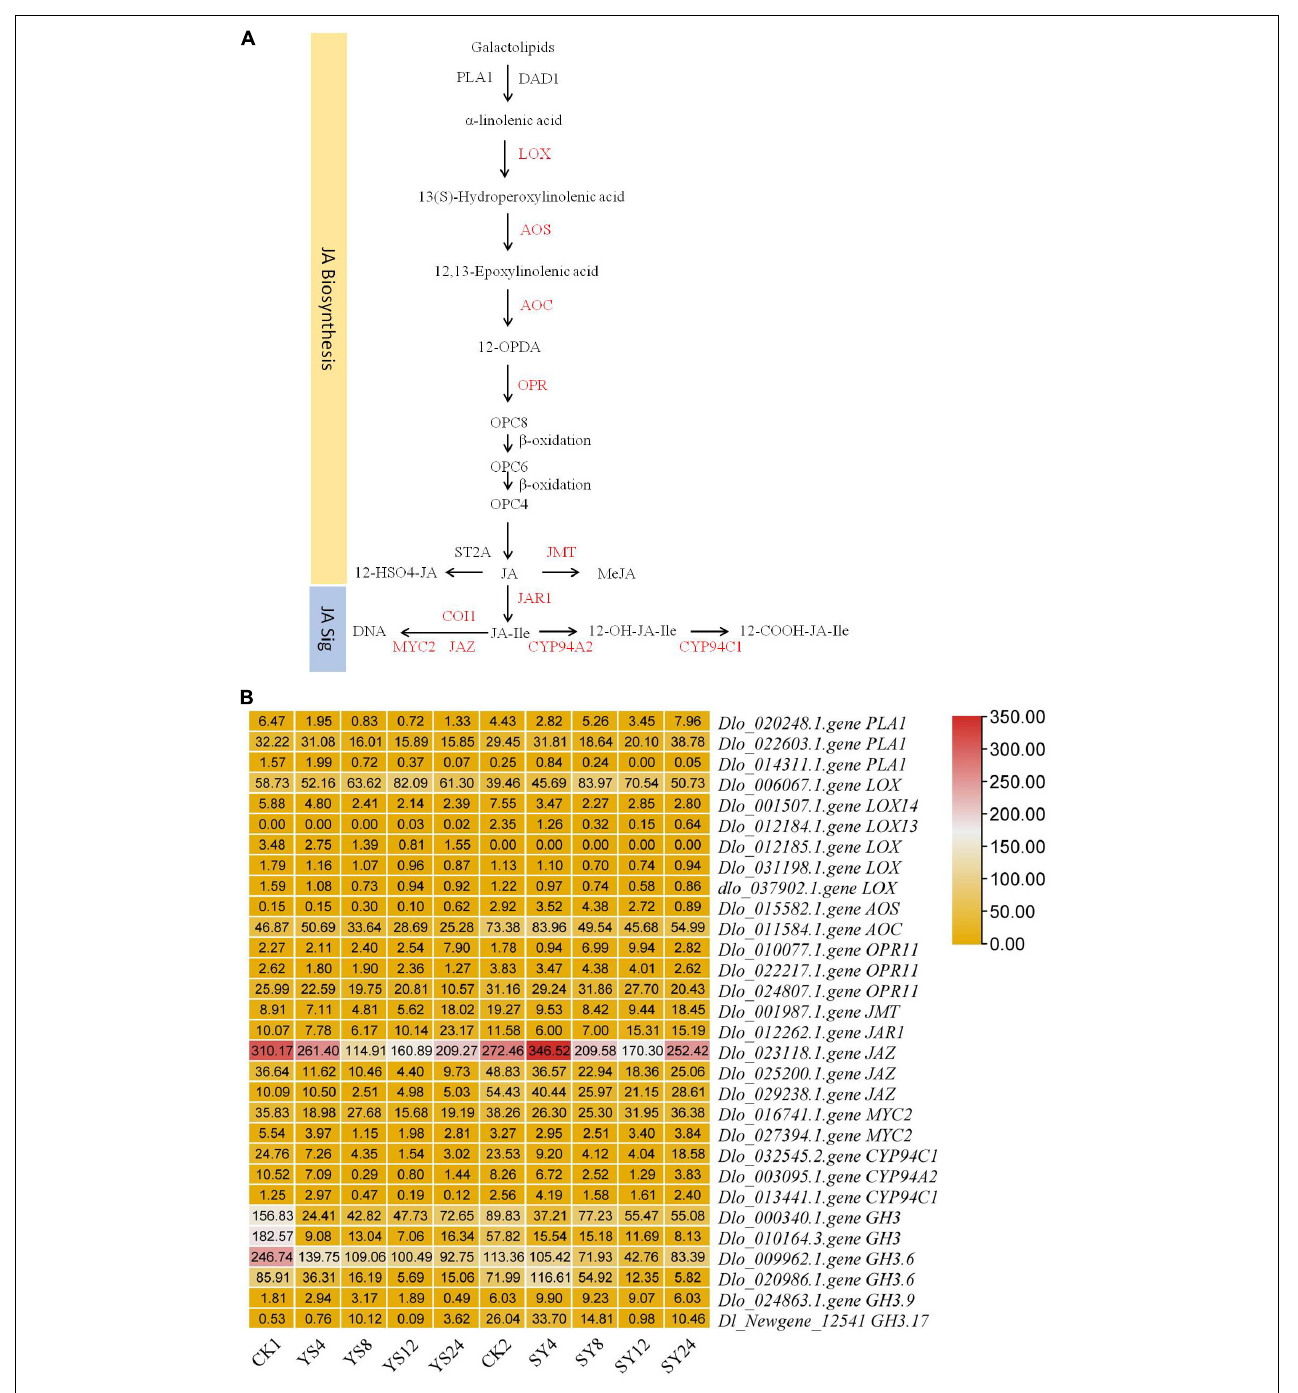
FIGURE 7 | Differential regulation of jasmonic acid metabolism and signaling in the YS and SY pollination combinations compared to their respective controls. (A) The pathway of Jasmonic acid metabolism and signaling. The red colored text represents the differentially regulated genes in the pathway. DAD1 (DEFECTIVE IN ANTHER DEHISCENCE 1), LOX (lipoxygenase), AOS (allene oxide synthase), AOC (allene oxide cyclase), OPR (OPDA Reductase), JMT (JA methyl transferase), ST2A (sulfotransferase 2A), JAR1 (Auxin-responsive GH3 family protein; jasmonic acid-amino synthetase), COI1 (coronatine-insensitive protein 1), JAZ (Jasmonate ZIM domain-containing protein), MYC2 (transcription factor MYC2), CYP94A2 (jasmonoyl-isoleucine 12-hydroxylase), and CYP94C1. Y, Yiduo; S, Shixia; CK1, Yiduo sepal-pistil before pollination; CK2, Shixia sepal-pistil before pollination. The numbers with treatments represent time after pollination. (B) The heatmap shows the FPKM values of differentially regulated